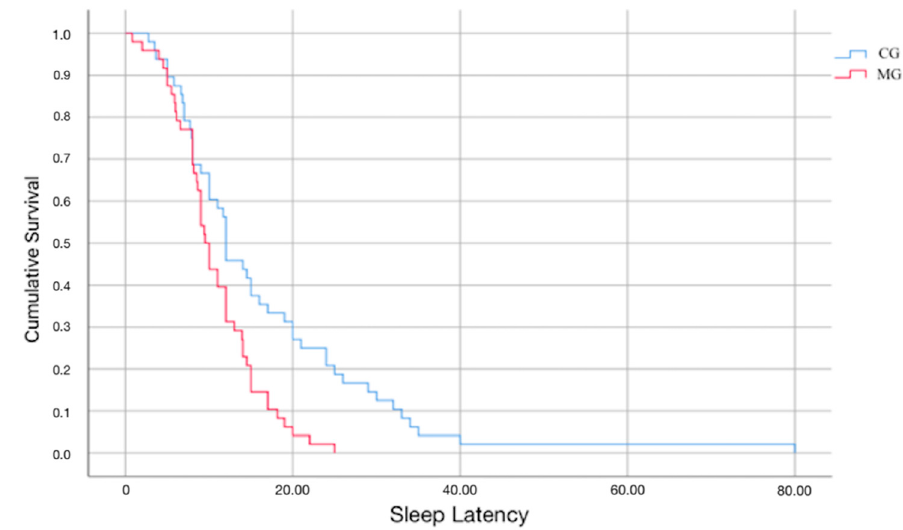
Figure 4. Kaplan–Meier curve for sleep latency in MG and CG.